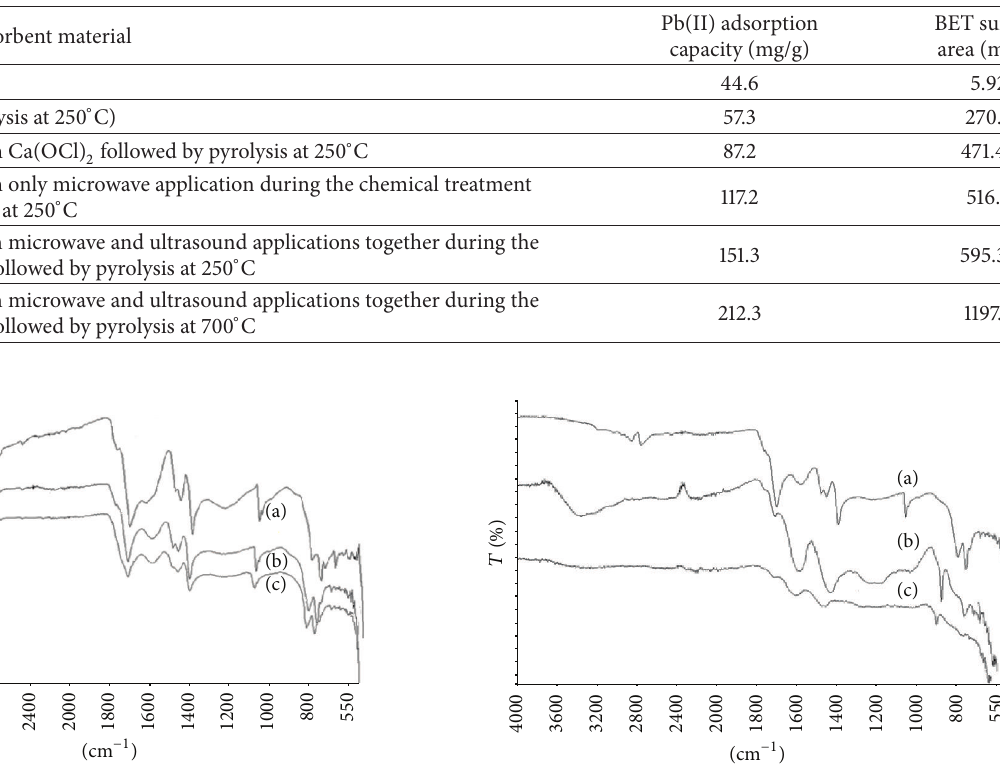
Figure 5: Spectra of (a) the chemically treated AC followed by pyrolysis at 250 ∘ C, (b) the physicochemically treated AC with only microwave application followed by pyrolysis at 250 ∘ C, and (c) the Pb(II)-loaded AC.